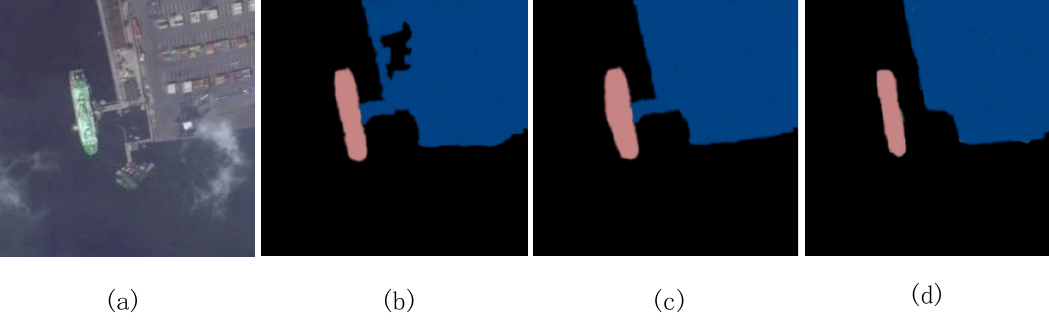
Figure 7. Semantic segmentation of ships within a port. ( a ) Original ( b )CRF-RNN ( c ) DeepLab ( d ) Proposed model.